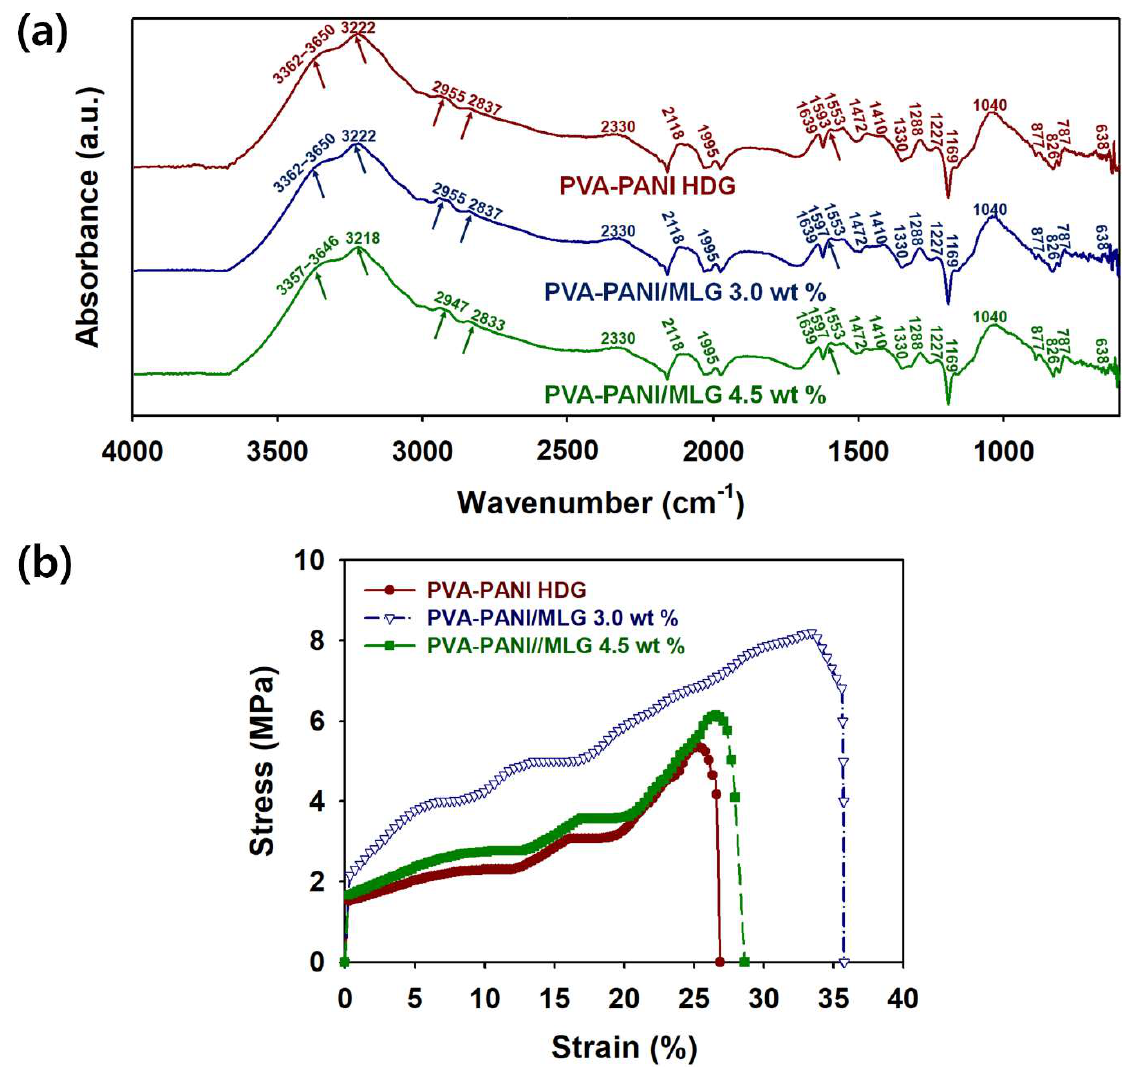
Figure 5. ( a ) FTIR spectra and ( b ) stress-strain (S-S) curves of PVA–PANI–MLG HDGs with different MLG contents: PVA–PANI (red), 3.0 wt.% MLG (blue), and 4.5 wt.% MLG (green). The concentration of PVA was fixed at 5 wt.%. Table 3. IR absorption bands of PVA–PANI–MLG HDGs.